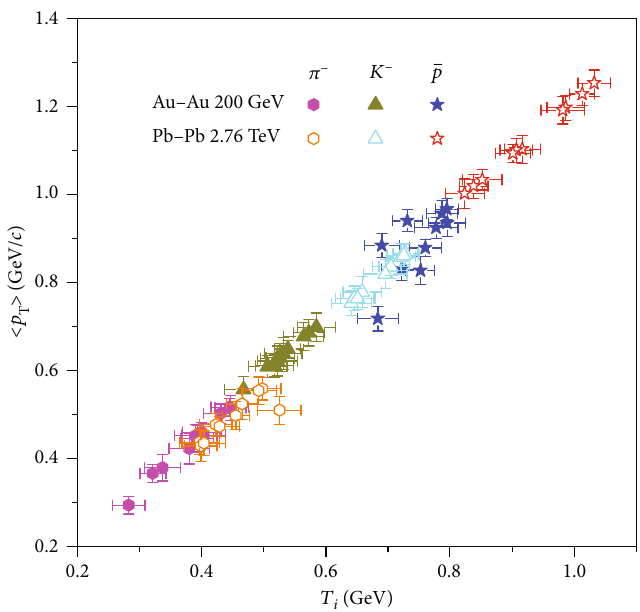
i on the initial temperature T T